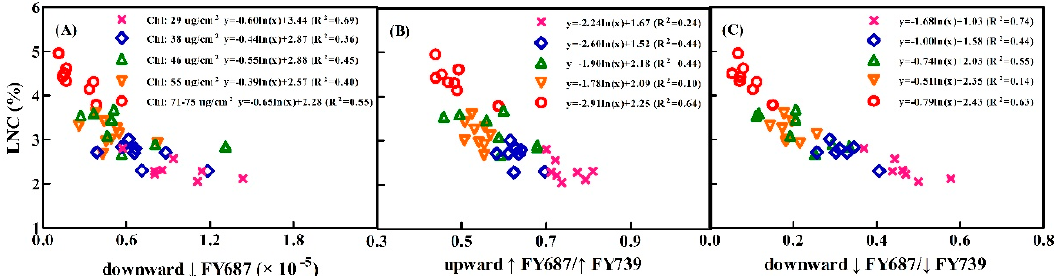
Figure 9. Effects of different Chl content on the relationships between SIF yield indices and LNC. ( A ) ↓ FY687 (×10 − 5) ; ( B ) ↑ FY687/ ↑ FY739; ( C ) ↓ FY687/ ↓ FY739.